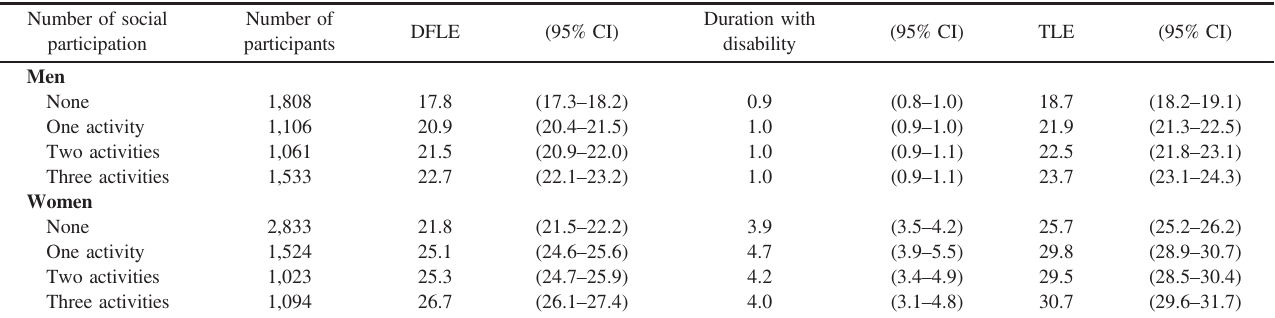
Table 3. DFLE, duration with disability and TLE at 65 years by the number of social participation ( n = 11,982) Number of social participation